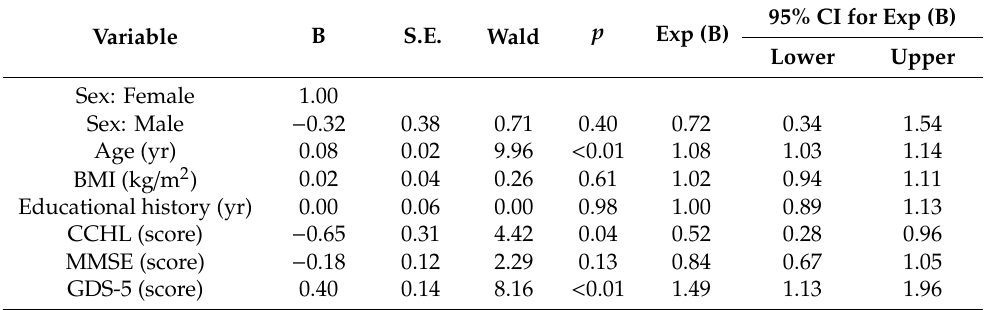
Table 3. Logistic regression analysis with the presence or absence of SCD as the dependent variable.